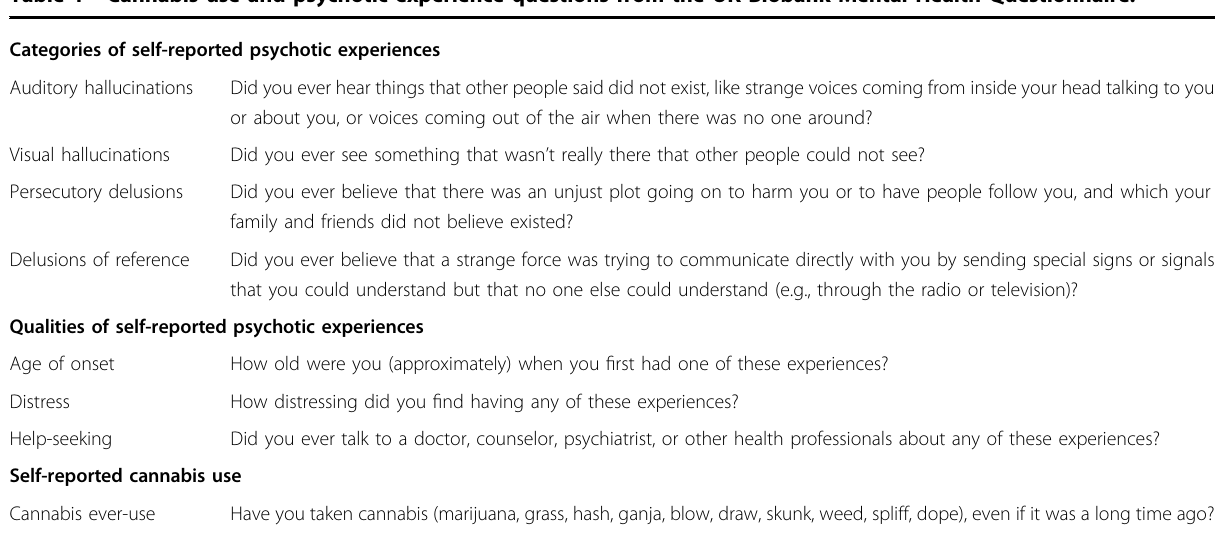
Table 1 Cannabis use and psychotic experience questions from the UK Biobank Mental Health